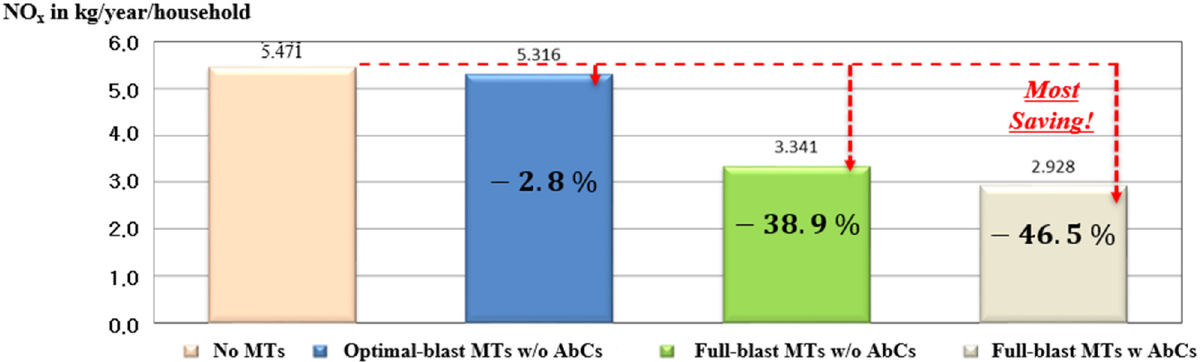
Figure 17. NO x emissions savings (scenario 2).